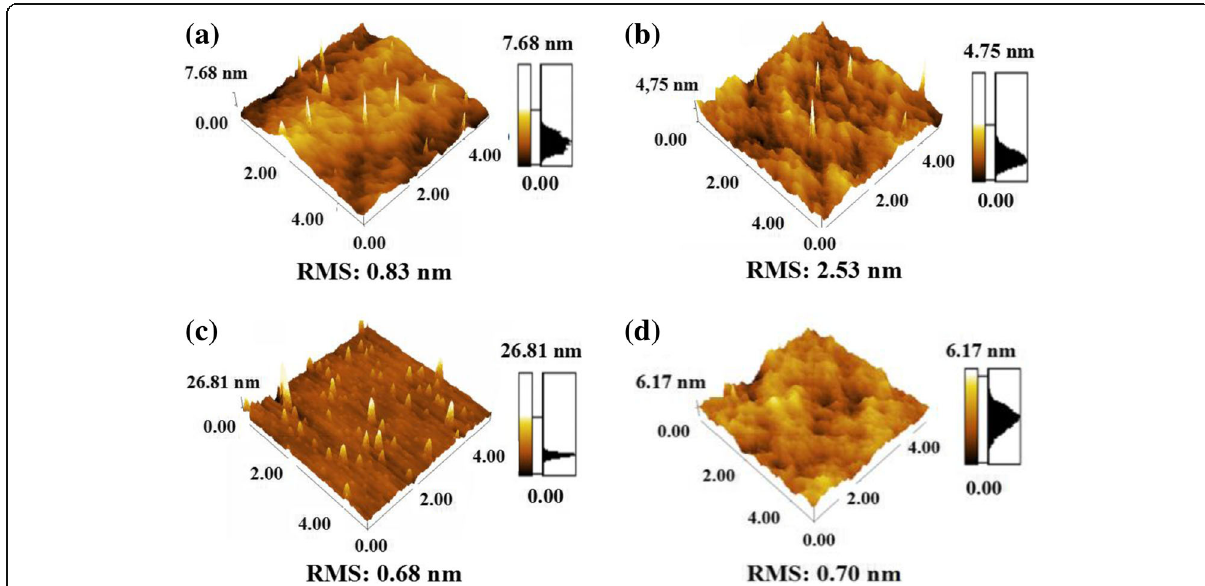
Fig. 6 AFM topography images of the exposed buffer layers: a ALD Al 2 O 3 , b EB Al 2 O 3 , c sputtered Al 2 O 3 , and d SiO 2